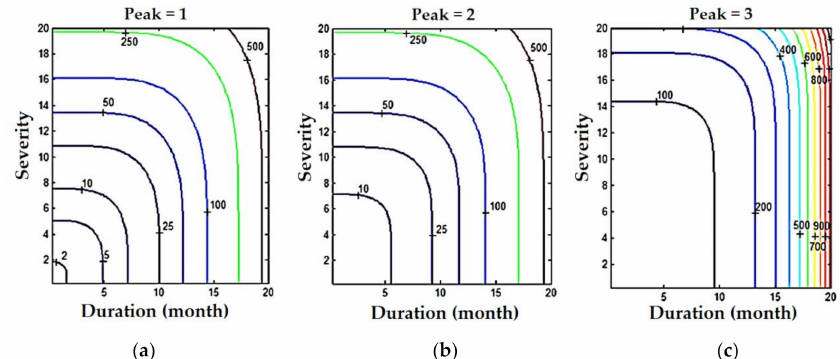
Figure 9. T ∨ curves for di ff erent values of severity peaks based on one-month TSI for the Rasht Basin: DSP 1 ( a ); 2 ( b ); and 3 ( c